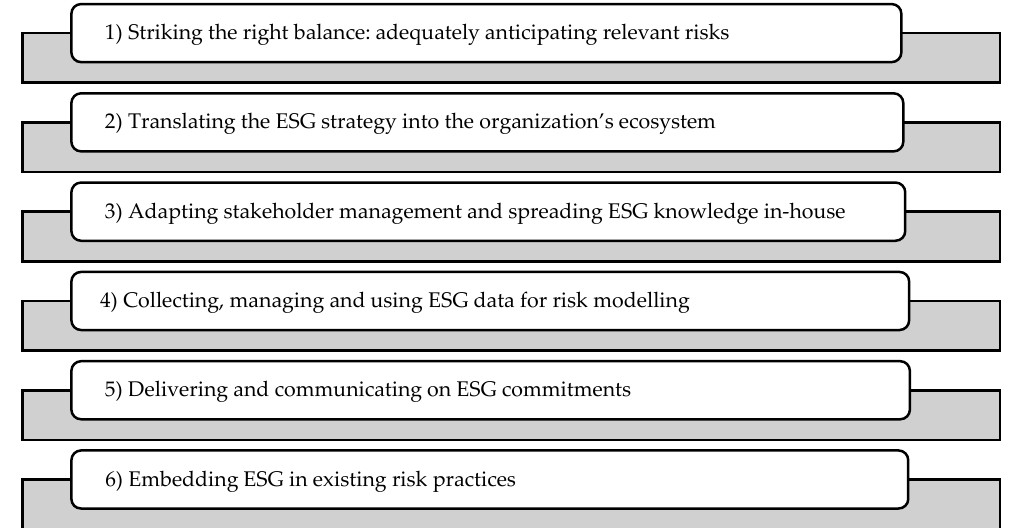
Figure 2. Six key challenges for European financial institutions to deal with ESG risks. Source: [67].